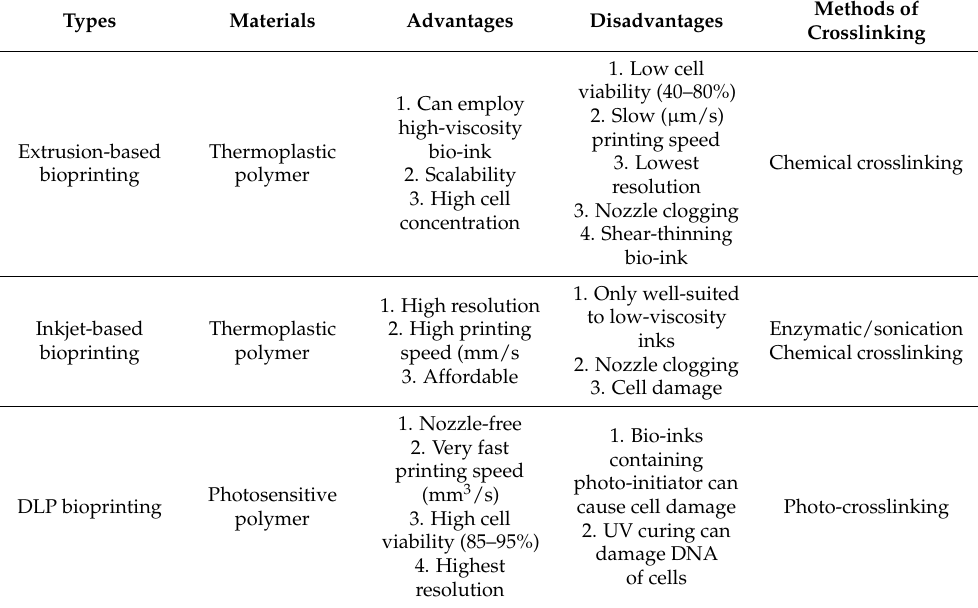
Table 1. Comparison of 3D DLP bioprinting with conventional 3D-printing technology including extrusion-based and inkjet-based bioprinting [6,7,11,12].